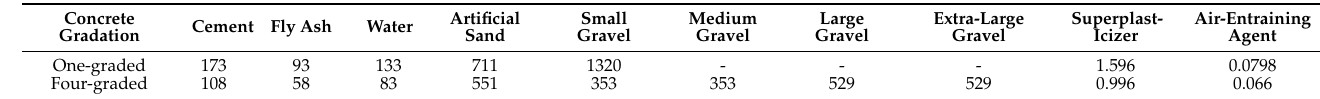
Table 1. Mix proportion of concrete (kg/m 3 ).